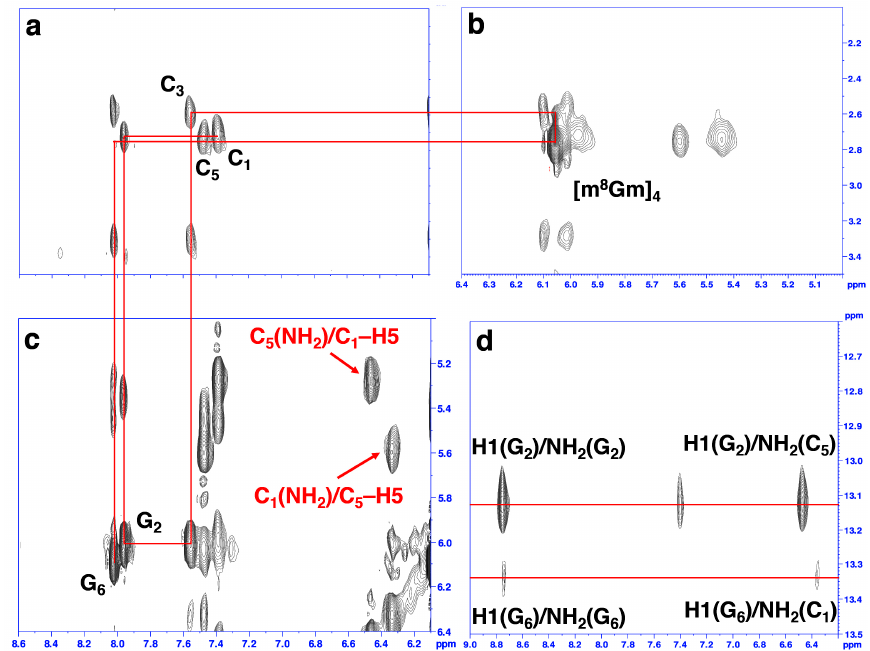
Figure 3. ( a – c ) H6/H5 (cid:48)(cid:48) of C and H8/H1 (cid:48) of G (8CH 3 /H1 (cid:48) of m 8 Gm) proton region of NOESY spectra of r(CGC[m 8 Gm]CG) 2 in NaClO 4 solution. The NOE connectivity pathway is shown as red line. Intraresidue NOE cross-peaks are labeled with residue numbers. The Z-RNA structure specific cross-peaks were observed between C 5 amino protons and C 1 H5 protons from the opposite strand (indicated as red words), as well as between C 1 amino protons and C 5 H5 protons from the opposite strand ( c ). ( d ) The cross peaks of imino proton of G 2 and amino proton of C 5 , as well as imino proton of G 6 and amino proton of C 1 , indicated Watson–Crick-type base pairs of Z-RNA. Intraresidue NOE cross-peaks of imino and amino proton of G 2 and G 6 are